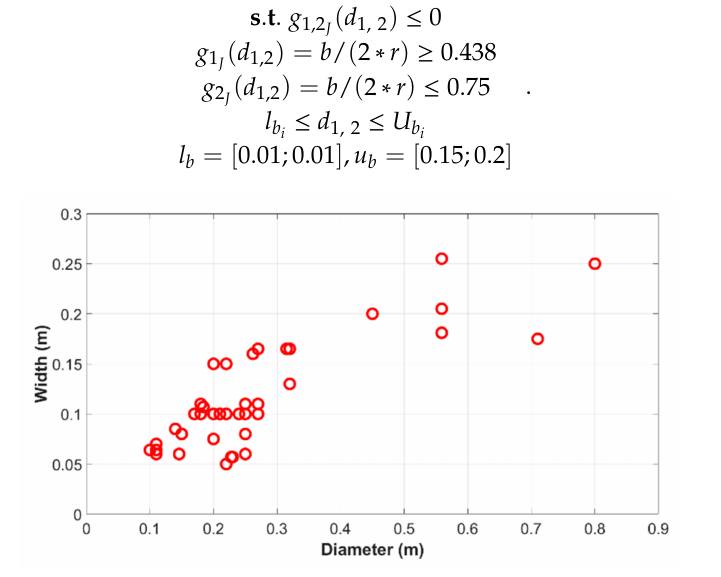
Figure 11. Wheel dimensions for previous and on-going development of exploration